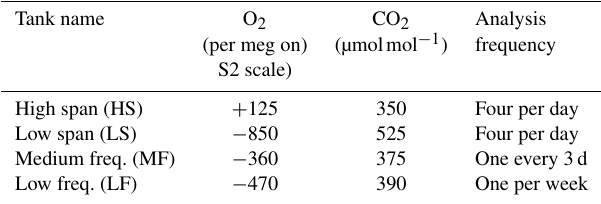
Table 1. Nominal composition of calibration tanks. Actual val- ues vary slightly as cylinders are used and refilled. The O 2 val- ues quoted here were measured in the lab of R. Keeling, while the CO 2 values were measured by the CCGG lab of NOAA ESRL GMD. Based on replicate measurements, the O 2 values are typi- cally determined to within roughly ± 1 . 5per meg on the S2 scale, while the CO 2 values on the WMO X2007 scale are known to about ± 0 . 2µmolmol − 1 (Hall, 2017). The cylinders are Luxfer N265 un- coated aluminum, with 51-14B regulators from Scott Specialty Gases (now Air Liquide). Tanks and regulators are stored horizon- tally in an insulated box to minimize thermal and gravitational frac-